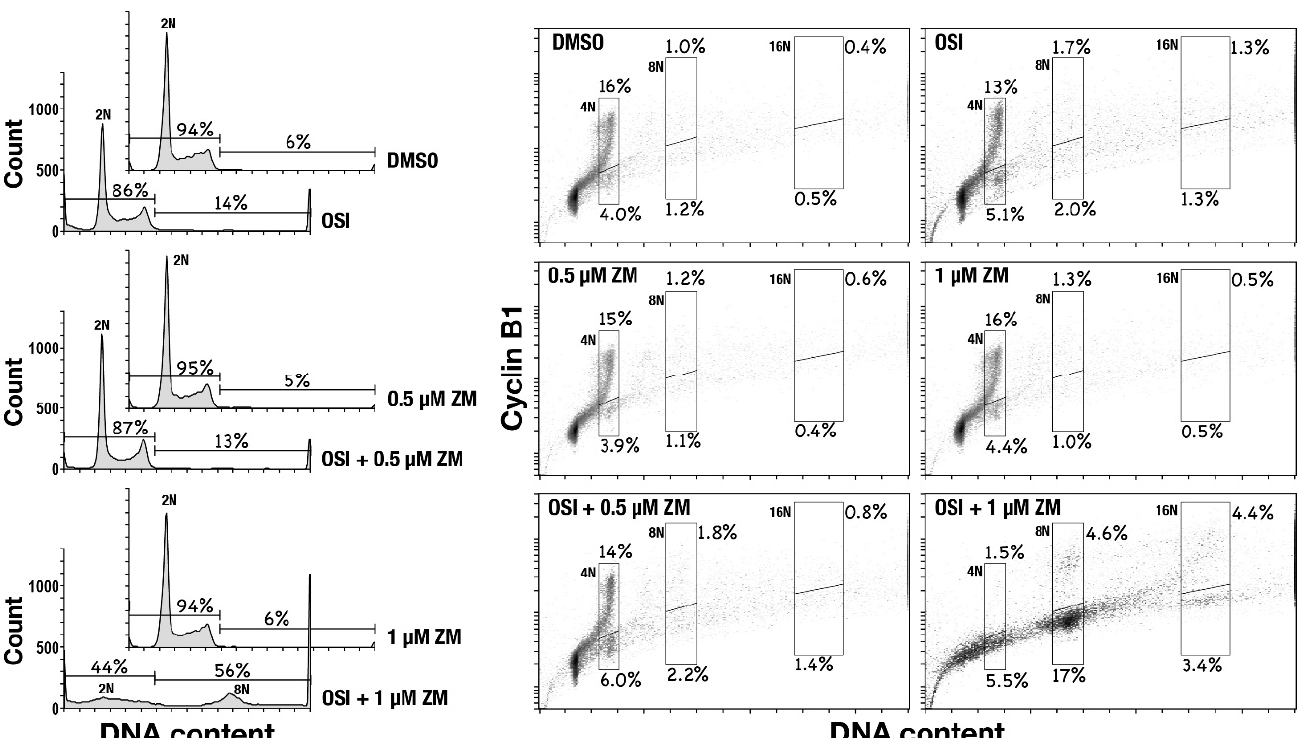
Figure 2. Combination of OSI-906 and ZM447439 causes over-replication. HeLa S3 cells were treated with 3 µM OSI-906, 0.5 or 1 µM ZM447439, or their combination for 48 h. The cells were detached from dishes, fixed with 70% ethanol for 1 h at –30 °C, and stained for cyclin B1 and DNA. DNA histograms are shown on the left. Peak haploid genome equivalents are indicated. Percentages of cells with more than 4N DNA content and less than that of DNA content are shown. Each plot represents 18,000 cells. The bivariate dot plots of 18,000 cells are shown on the right; DNA content is shown on the x-axis (linear scale), while cyclin B1 protein level is shown on the y-axis (log scale). Regions designated by line include cells having 4N, 8N, or 16N DNA content, while lower and upper regions include cyclin B1-negative and -positive cell populations, respectively. Percentage of cell numbers within the region to the whole cell number is shown near the region.